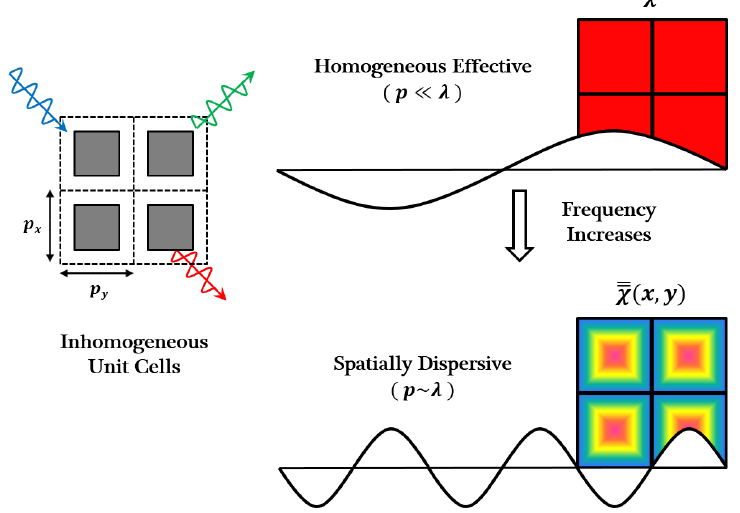
Figure 4. Homogeneous effective and spatially dispersive